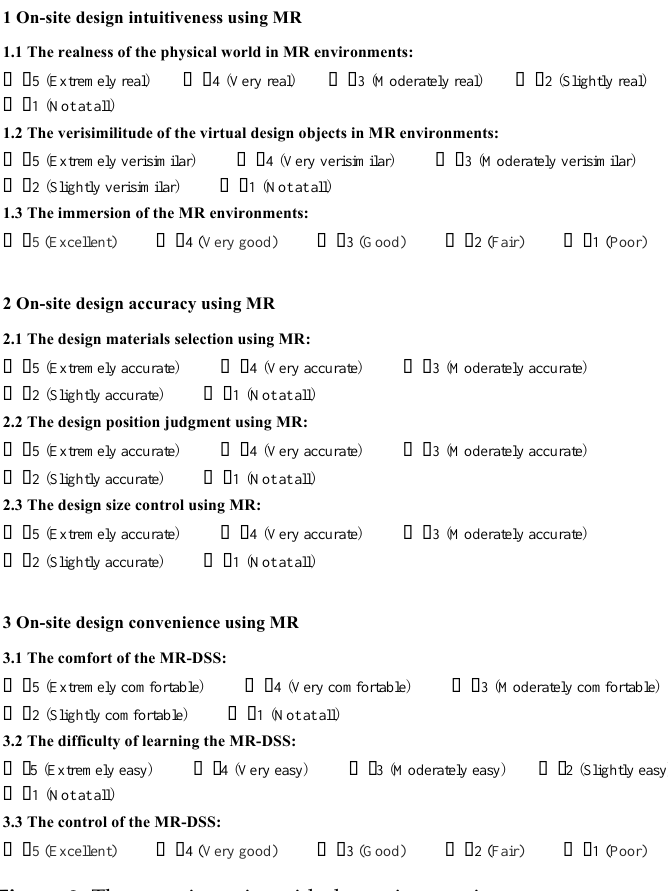
Figure 9. The questionnaire with the main questions.